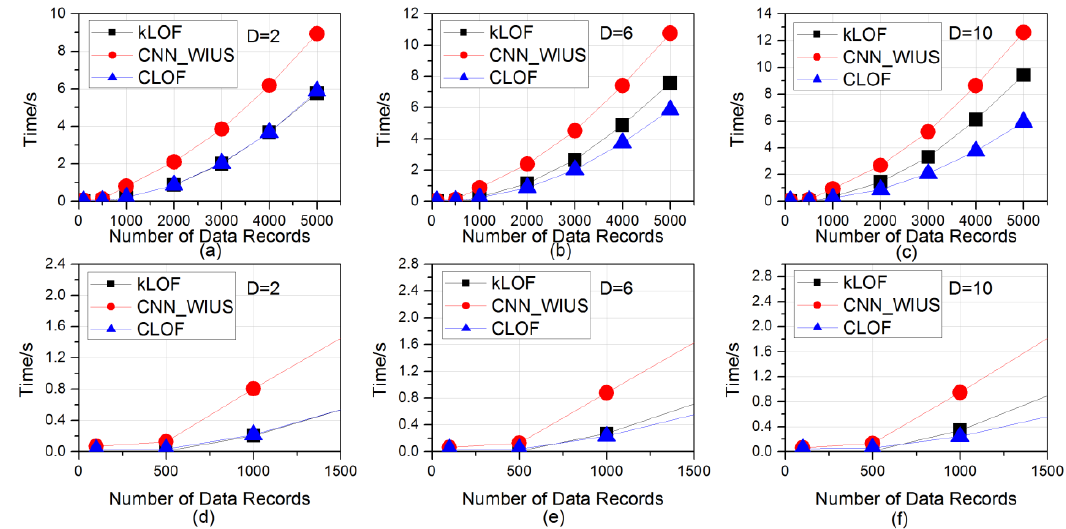
Figure 9. The further analysis of updating time on standard Gaussian distribution synthetic datasets: ( a – c ) the time at k = 5, D = 2, 6, 10, and N = 100, 500, 1000, 2000, 3000, 4000, and 5000 respectively; ( d – f ) the time at k = 5, D = 2, 6, 10 and N = 100, 500, 1000 respectively.